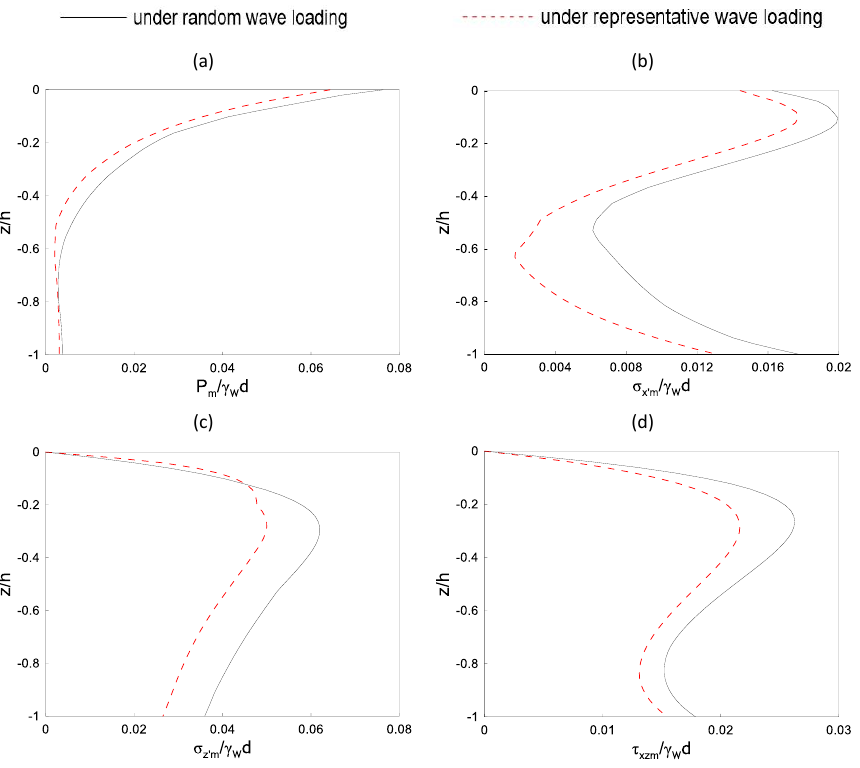
Figure 20. Distribution of the maximum soil response under the random wave and representative regular wave loading. ( a ) Pore pressure p m , ( b ) horizontal effective normal stress σ (cid:48) xm , ( c ) vertical effective normal stress, and σ (cid:48) zm ( d ) shear stress τ xzm